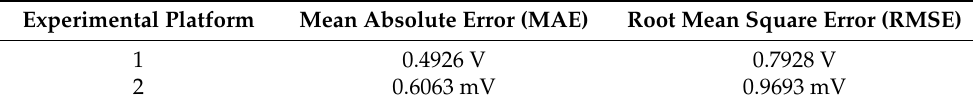
Table 2. The predicted error for modeling the noise measured in experimental platform 1 and